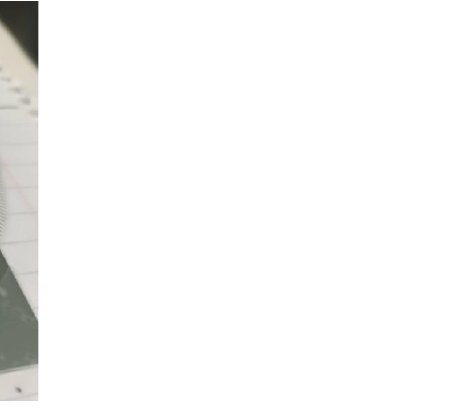
Figure 19. Experimental configuration offset by 5 mm; previous position marked by a blue outline.